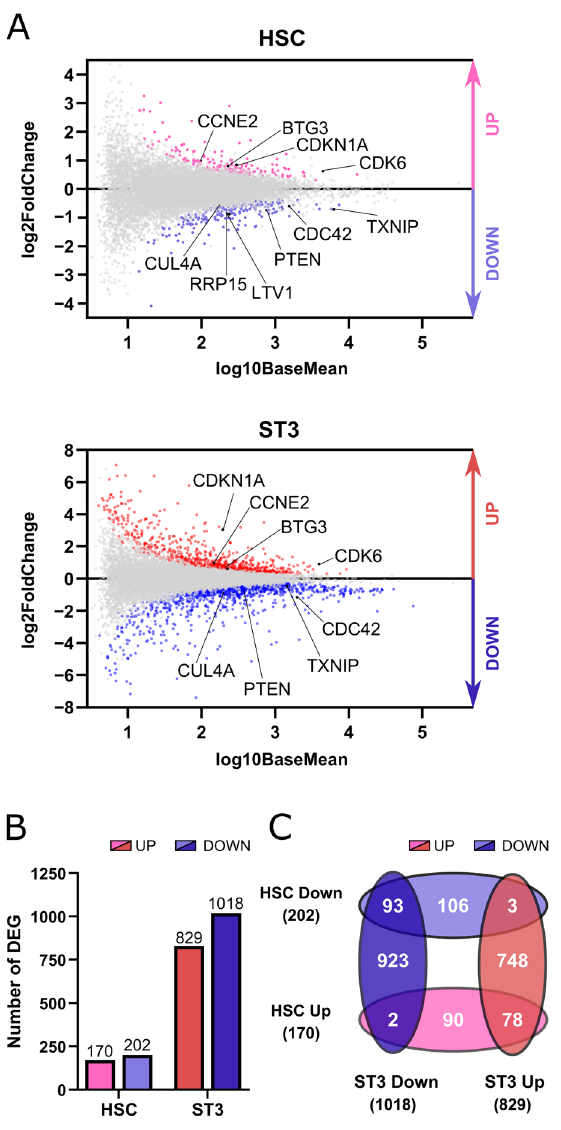
Figure 2. TXNIP knockdown affects the transcriptome of HSC and stage 3 cells. RNA sequencing was performed on five biological replicates of HSC and ST3 cells sorted from TXNIP knockdown cultures on d3 and d7, respectively. ( A ) MA plots showing up- (red) and downregulated (blue) genes in HSC and ST3 cells. ( B ) Bar graphs showing the number of differentially expressed genes (DEG) in HSC and ST3 that were up- (red) or downregulated (blue). ( C ) Venn diagram showing the overlap between the DEGs in the HSC and ST3 populations. Table 1. The top five enriched biological processes in up- and downregulated differentially ex- pressed genes.